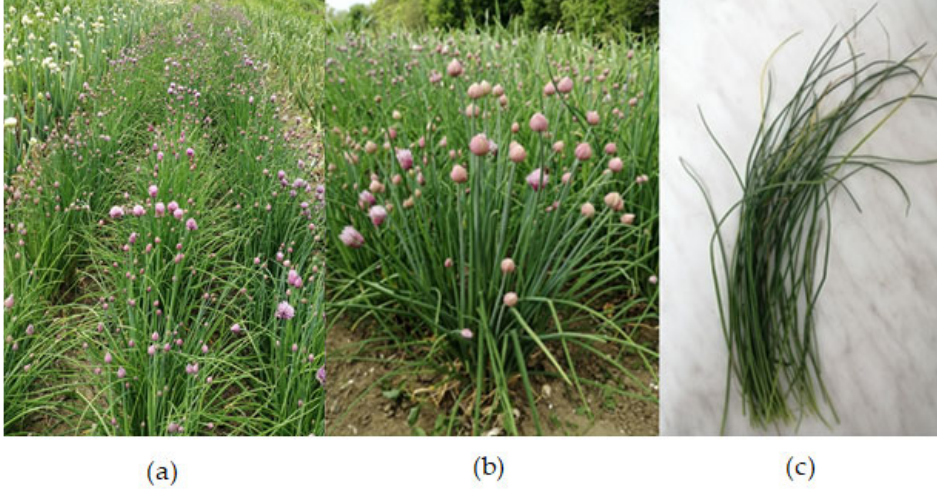
Figure 4. Appearance of A. schoenoprasum ( a , b ); edible parts (leaves) of A. schoenoprasum ( c ). Edible parts (leaves) (Figures 3 and 4c) were collected using a completely random